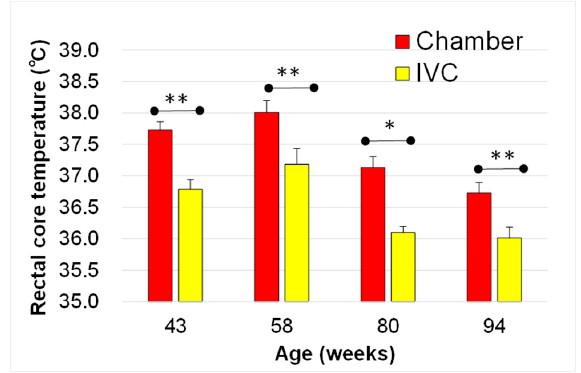
Figure 4. Changes in rectal core temperature with aging in the chamber and the IVC groups. ** p < 0.01; * p < 0.05 by t-test.